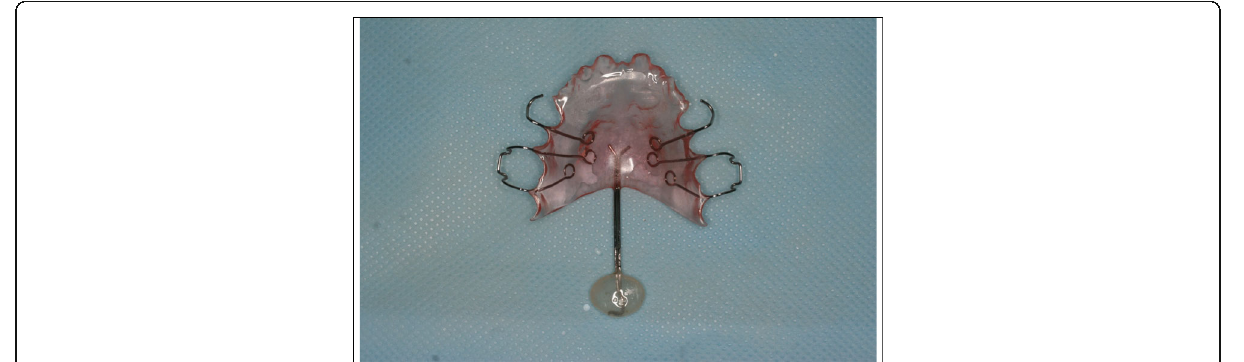
Fig. 3 Palatal lift: the functional part can elevate the soft